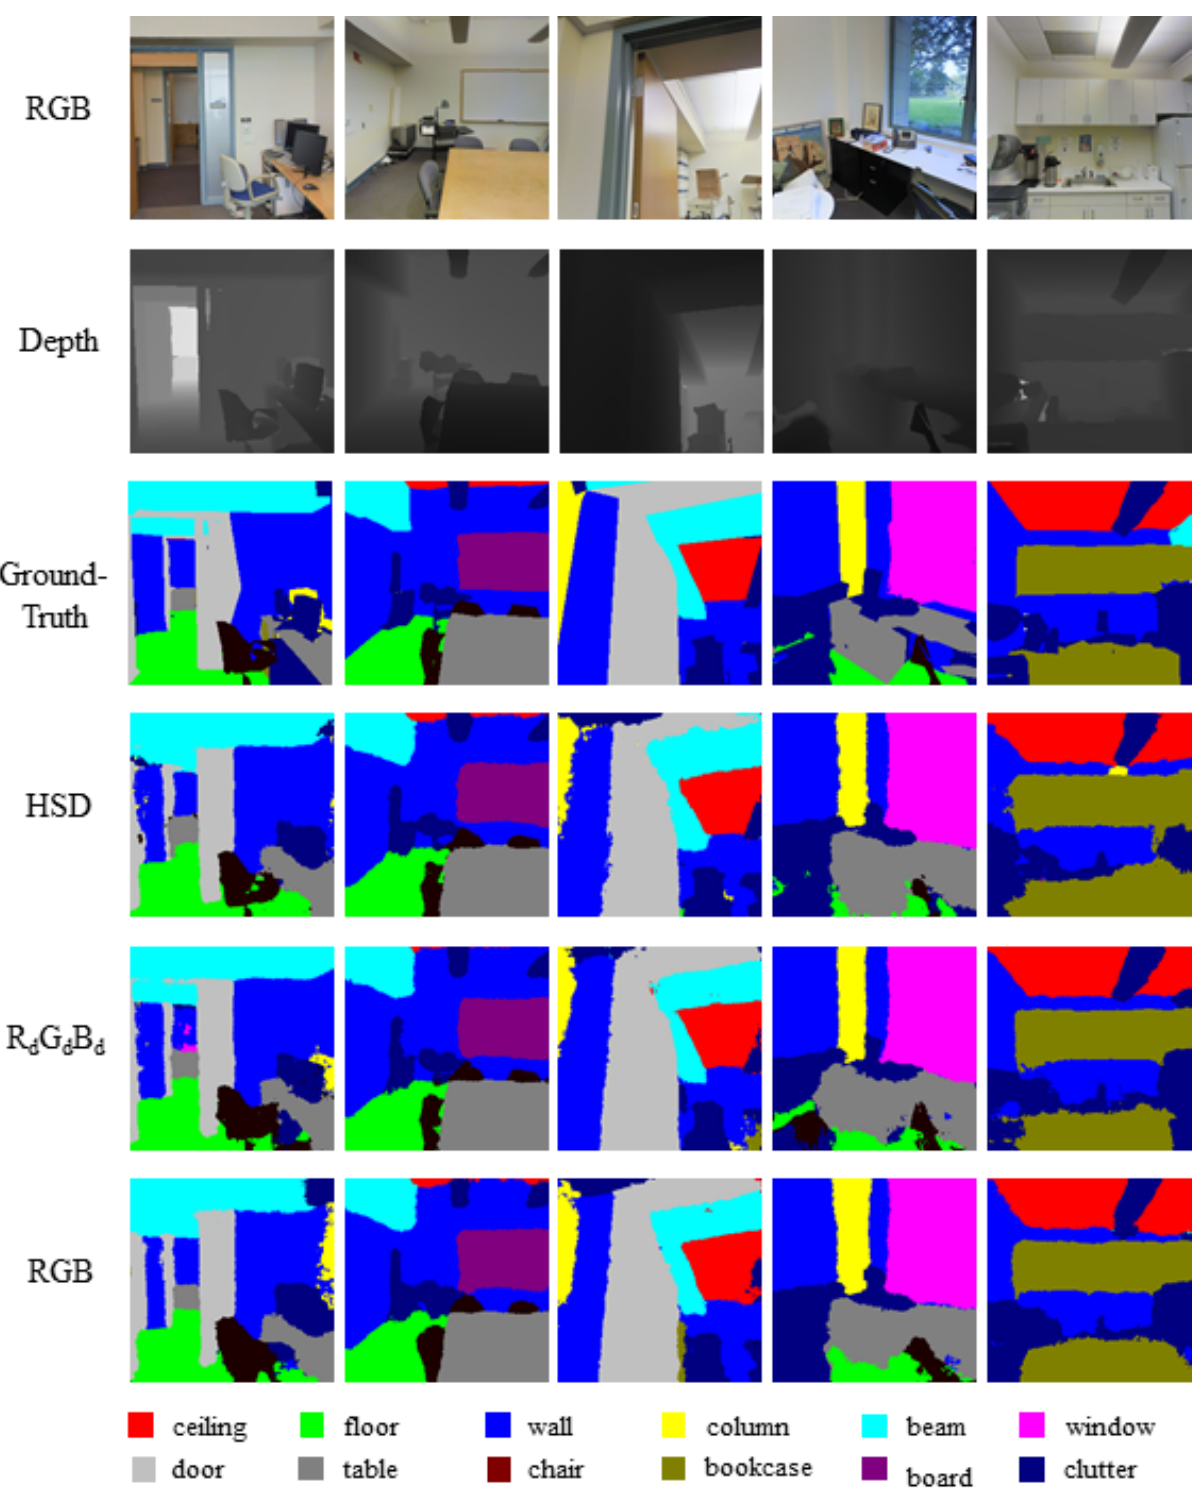
Figure 4. Results of the label